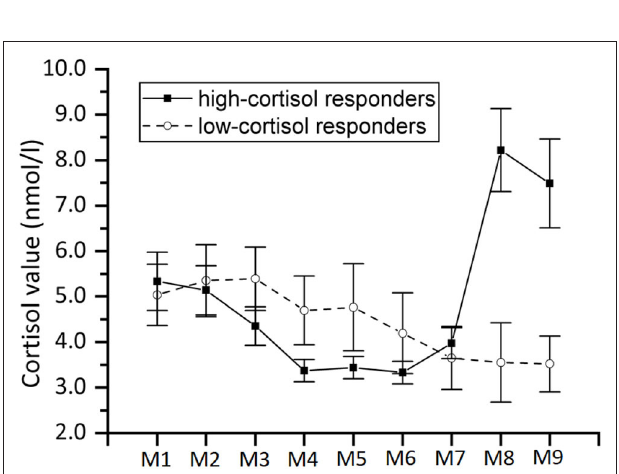
FIGURE 7 | Same as Figure 6 but with separate curves for high-cortisol responders ( n = 34) and low-cortisol responders ( n =